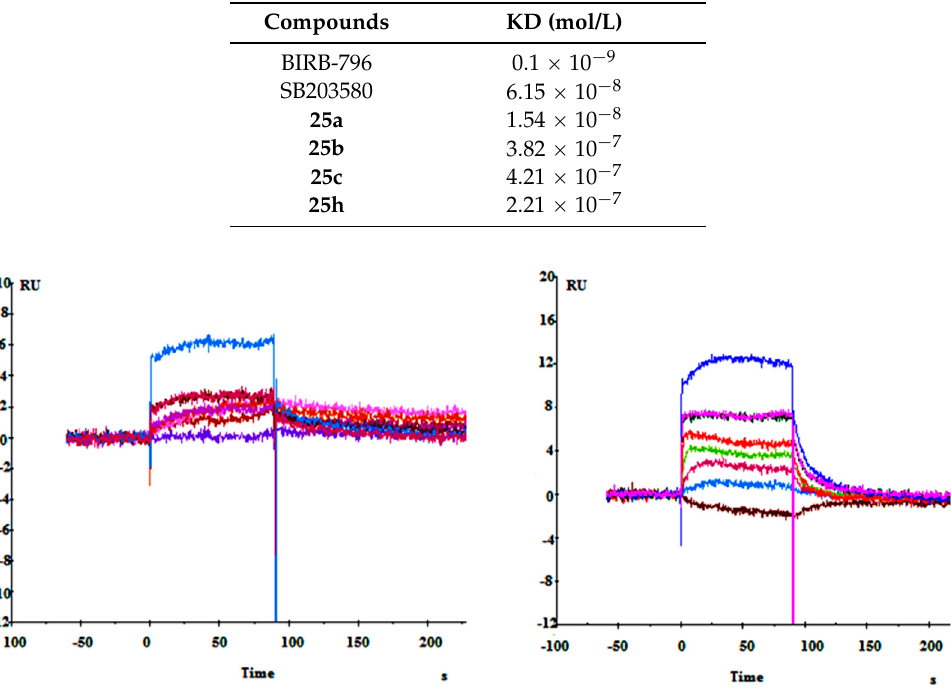
Figure 2. p38 α affinity measurement and analysis chart for 25a ( left ); and SB203580 ( right ). Concentration series (0.003–1 μ M) of inhibitor with different color lines enzyme kinetic characteristics were determined by surface plasmon resonance on the inactive form of the kinase using a Biacore instrument.